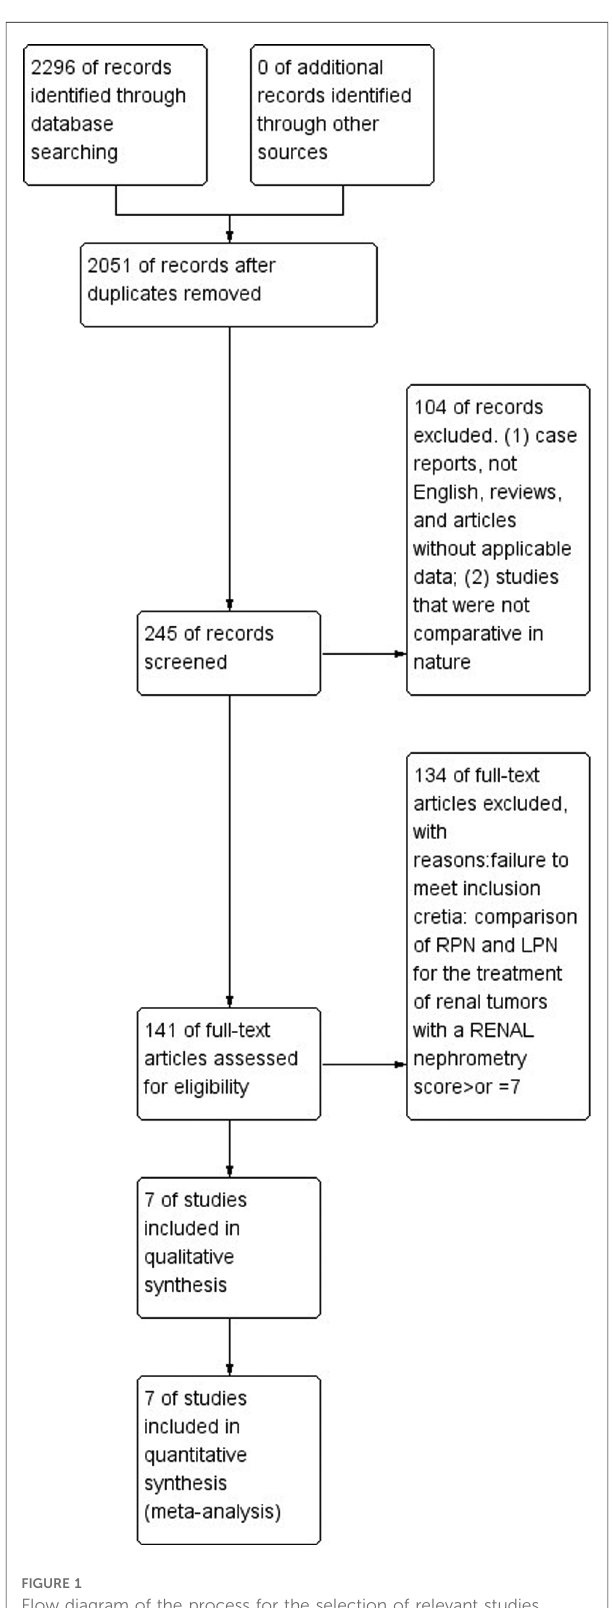
FIGURE 1 Flow diagram of the process for the selection of relevant